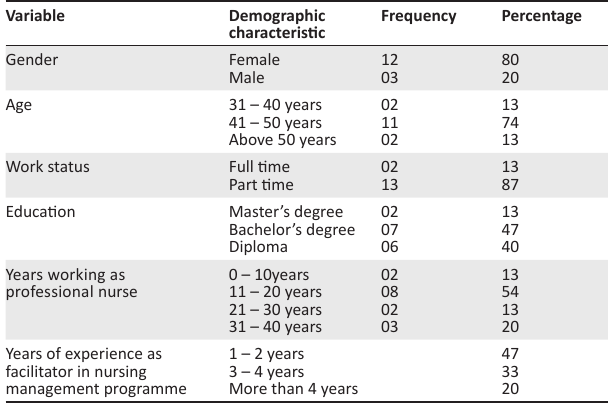
TABLE 1: Demographic and professional characteristics of facilitators ( N = 15).